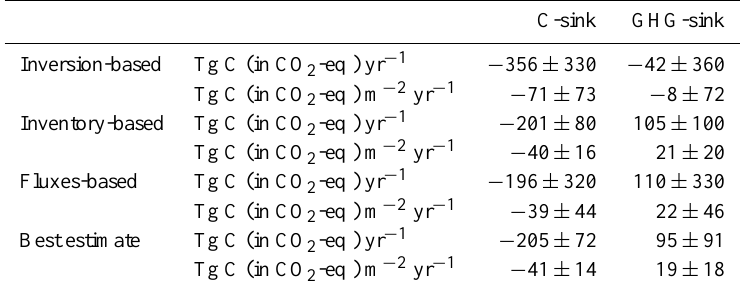
Table 4. Three quasi-independent estimates of the land-based carbon (Tg C yr − 1 ) and GHG (Tg C in CO 2 -eq yr − 1 ) balances of Europe between 2001 and 2005. The inversion-based estimate is based on Eq. (8), the flux-based estimate on Eq. (9) and the inventory-based estimate on Eq. (10). The C-balance accounts for CO 2 , CH 4 , CO and other C-fluxes. The GHG balance accounts for CO 2 , CH 4 , CO, other C-fluxes and N 2 O. Fluxes per unit area were calculated for a European surface area of 5035147km 2 . C-sink GHG-sink